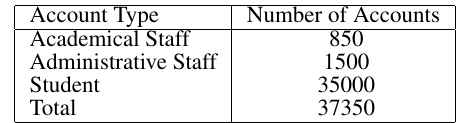
Table 1. Account Number Statistics